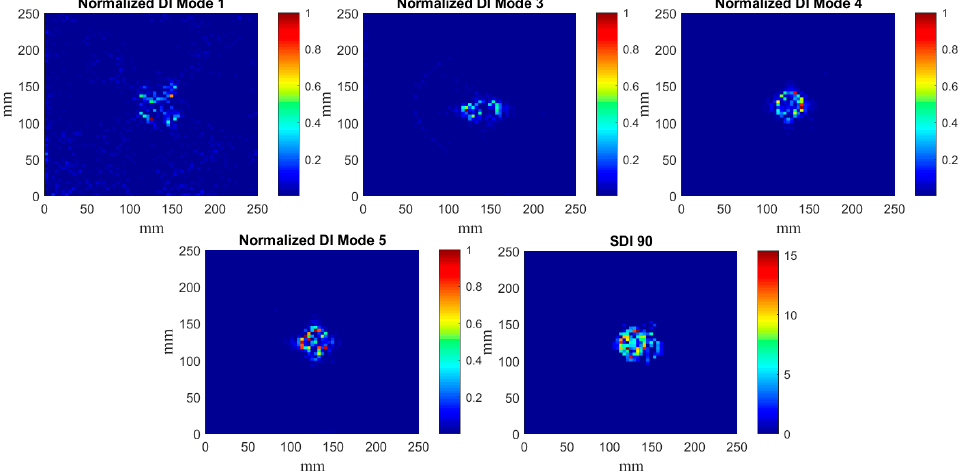
Figure 9. The determined normalized DIs for the mode shapes for the plate {2} and SDIs with the 90% confidence level.